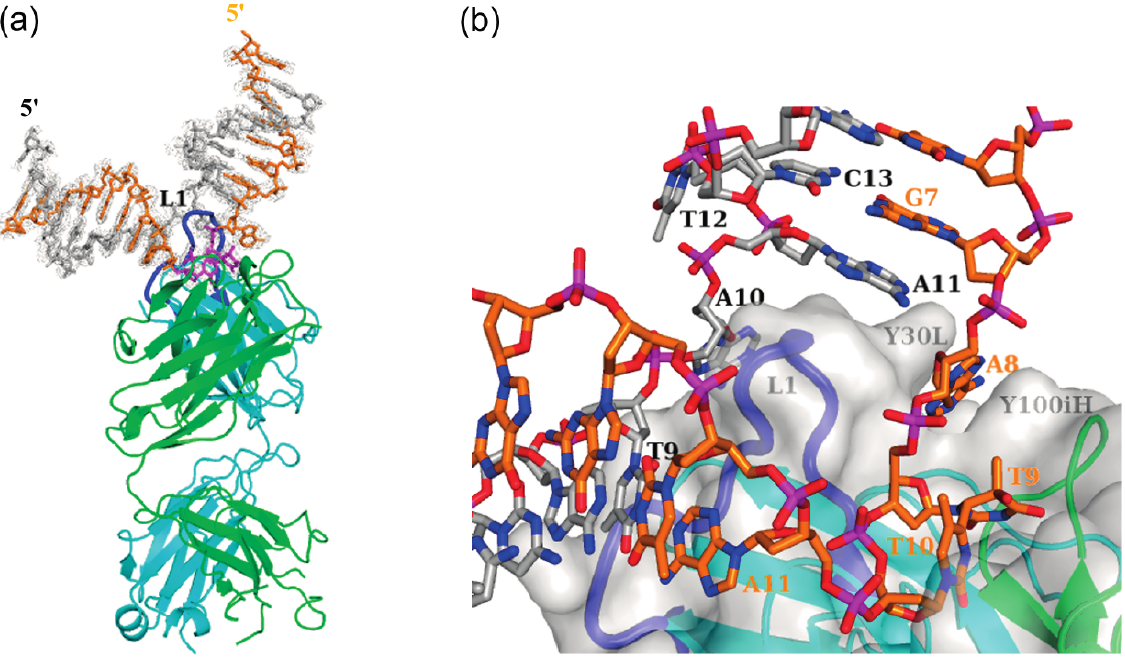
Figure 4. Overall structure of the 64M-5 Fab—ds-(6-4) DNA complex (PDB ID: 3VW3). ( a ) DNA is shown as stick models with the omit F o – F c electron density map (1.5 σ level). The T(6-4)T segment is drawn in magenta, the T(6-4)T-containing strand in orange (the 5'-end is labeled in orange), and the complementary strand in grey (the 5'-end is labeled in black). The heavy chain of Fab is drawn in green, and the light chain in cyan. The CDR L1 loop inserted between the T(6-4)T-containing strand and the complementary strand is drawn in blue; and ( b ) Close-up view. The Fab is also represented as a grey surface model. The T(6-4)T-containing strand is labeled in orange, and the complementary strand in black. (Reproduced and slightly modified from reference [14] with the permission of the International Union of